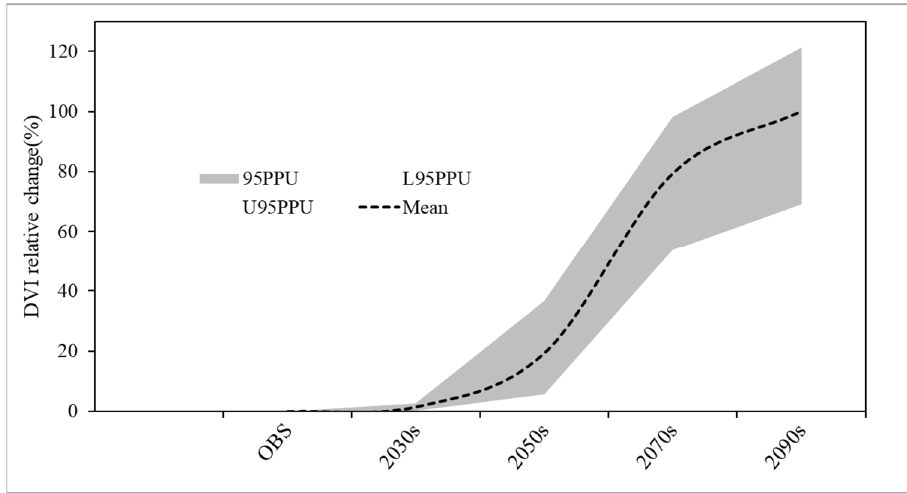
Figure 11. DVI’s mean regional uncertainty over northeast of Iran.